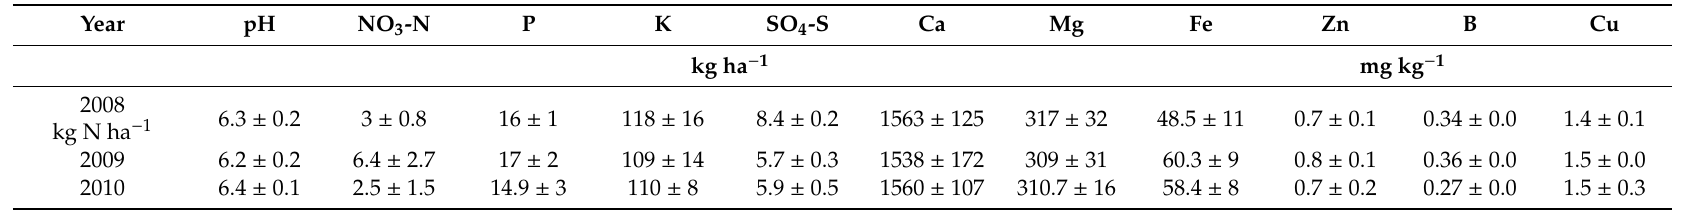
Table 1. Soil pH and plant available nutrients tested by year (2008, 2009 and 2010). Samples taken prior to